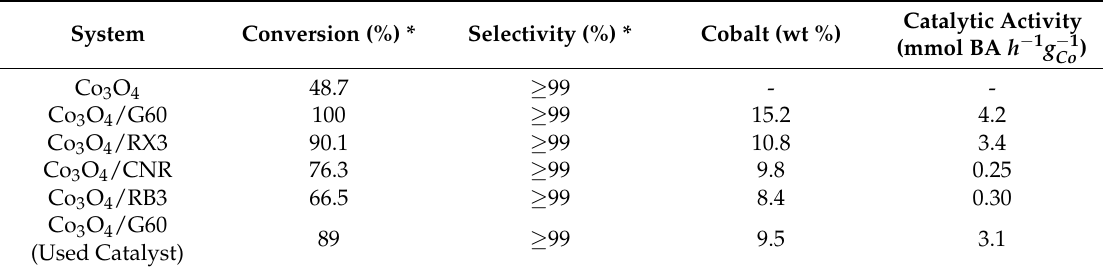
Table 4. Catalytic activity of Co 3 O 4 /AC